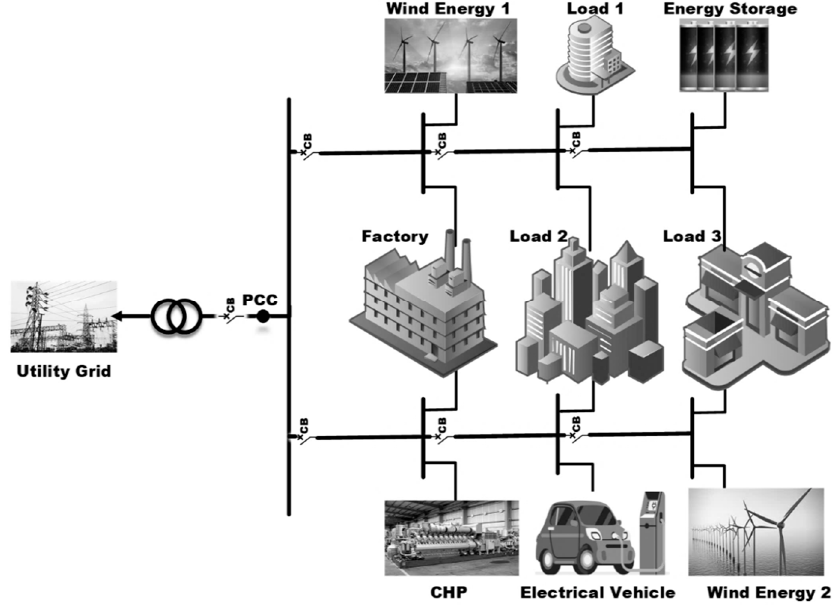
Figure 2. Single line diagram of a microgrid connected to the grid; CHP: combined heat and power CB: circuit breaker